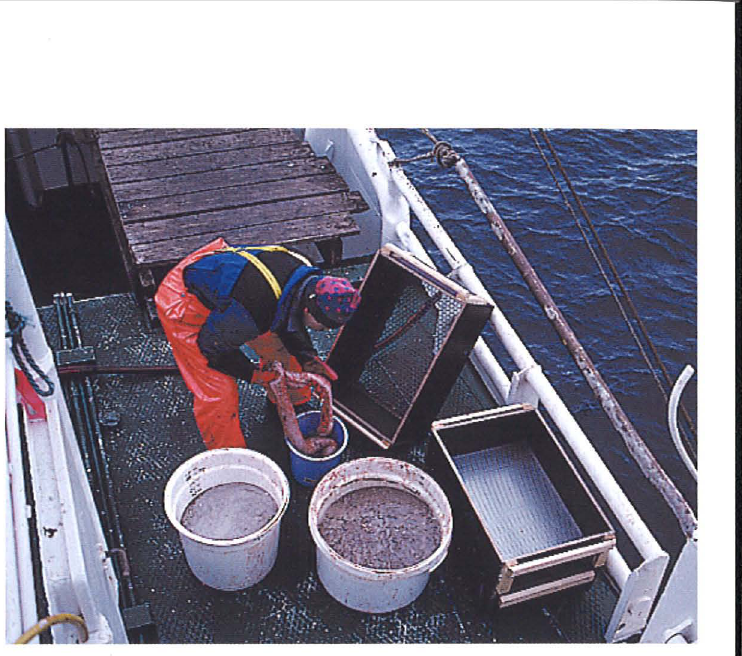
Fig. I: Sieves are used to sort the stomach and intestinal con tents of a lIIinke